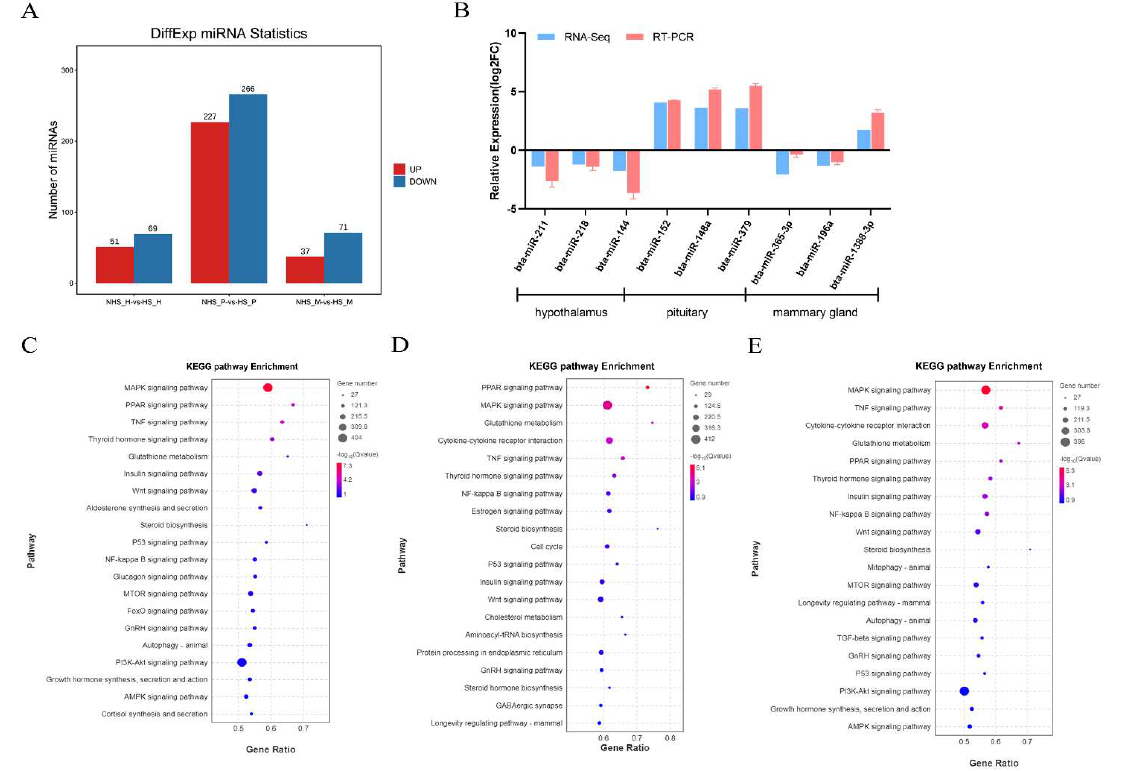
Figure 6. ( A ) Statistics of differential expression of miRNAs. ( B ) Comparison of the miRNAs expression levels determined by RNA-seq and RT-qPCR. ( C – F ) KEGG pathway analysis on the target genes of DE miRNAs in the hypothalamus, pituitary and mammary gland in dairy cows under heat stress.